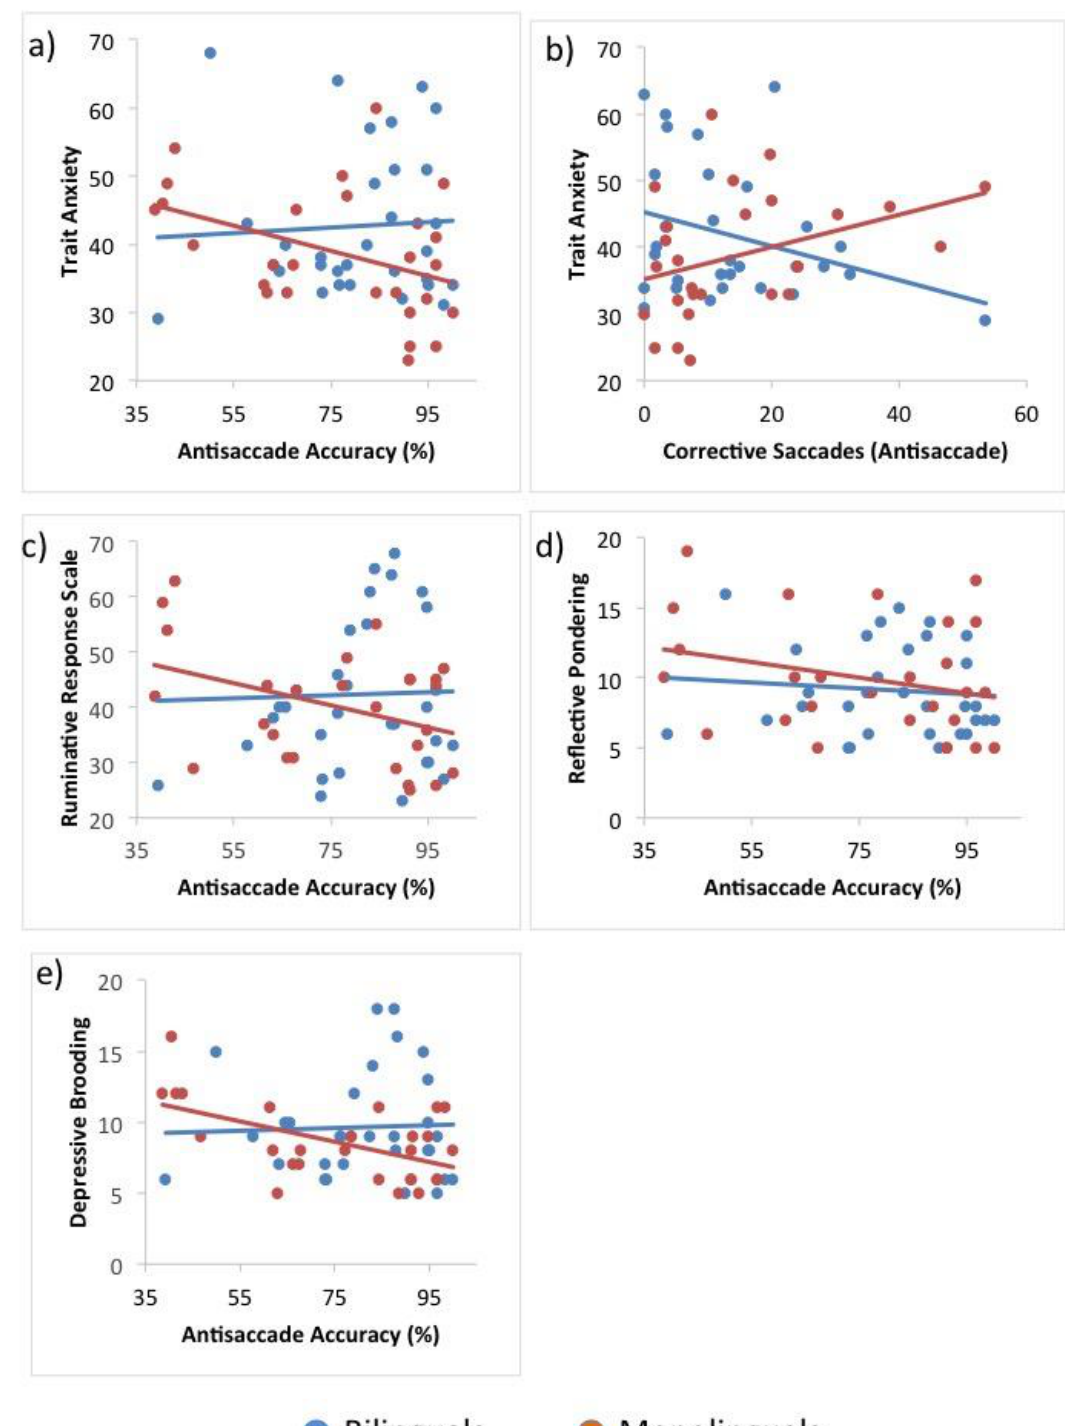
Figure 2. The effects of ( a ) trait anxiety on antisaccade accuracy; ( b ) trait anxiety on percentage of corrective saccades; ( c ) Ruminative Response Scale (RRS) score on antisaccade accuracy; ( d ) reflective pondering on antisaccade accuracy; and ( e ) depressive brooding on antisaccade accuracy in monolinguals and bilinguals.